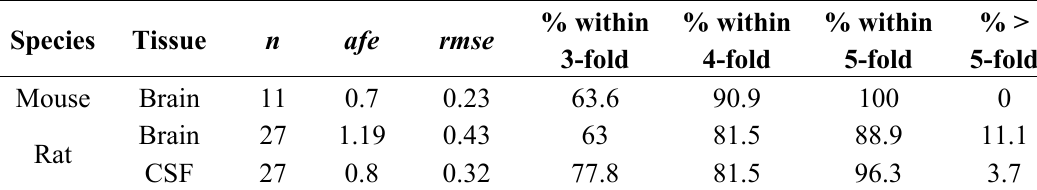
Table 3. Statistics for the model